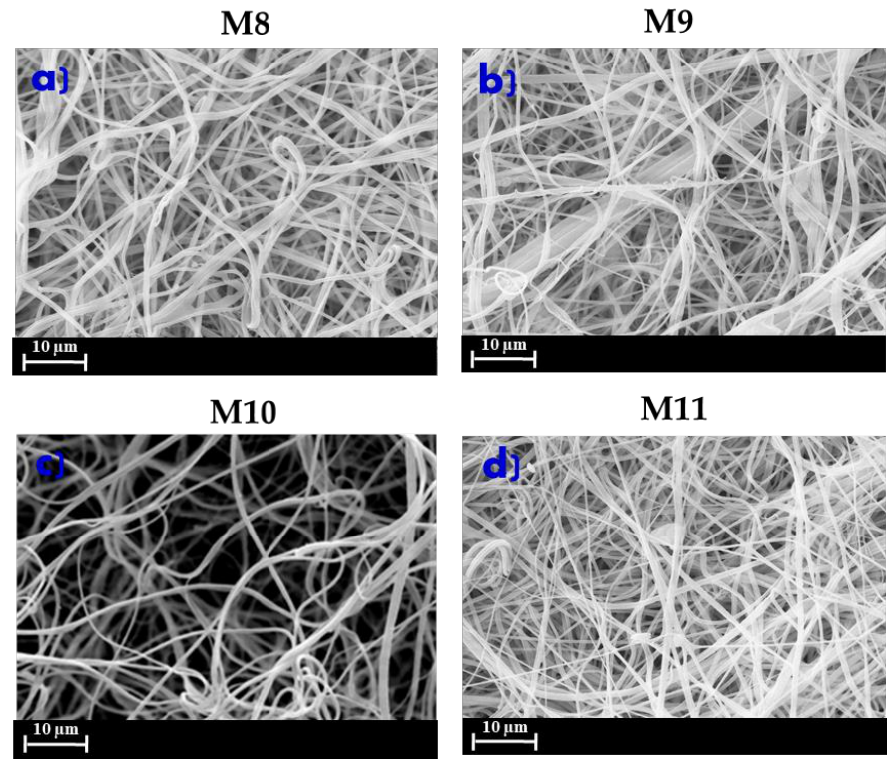
Figure 5. SEM pictures of ENMs using DMSO/acetone as a mixture of solvents at different voltages (( a ) and ( b ): M8 and M9 membranes) and needle to collector distance (( c ) and ( d ): M10 and M11 membranes) .